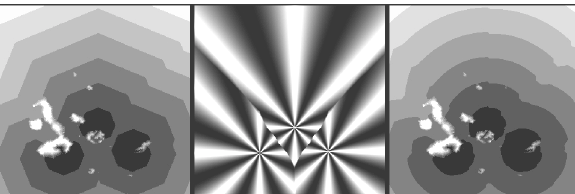
Figure 2: Octagonal-shaped results from cost-distance functions (left). Correction layer (middle). Corrected cost-distance